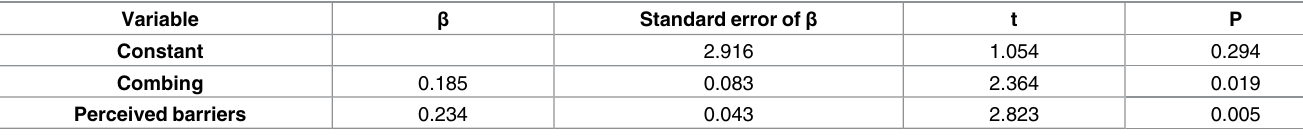
Table 5. Results of regression analysis to predict behaviors preventing pediculosis.